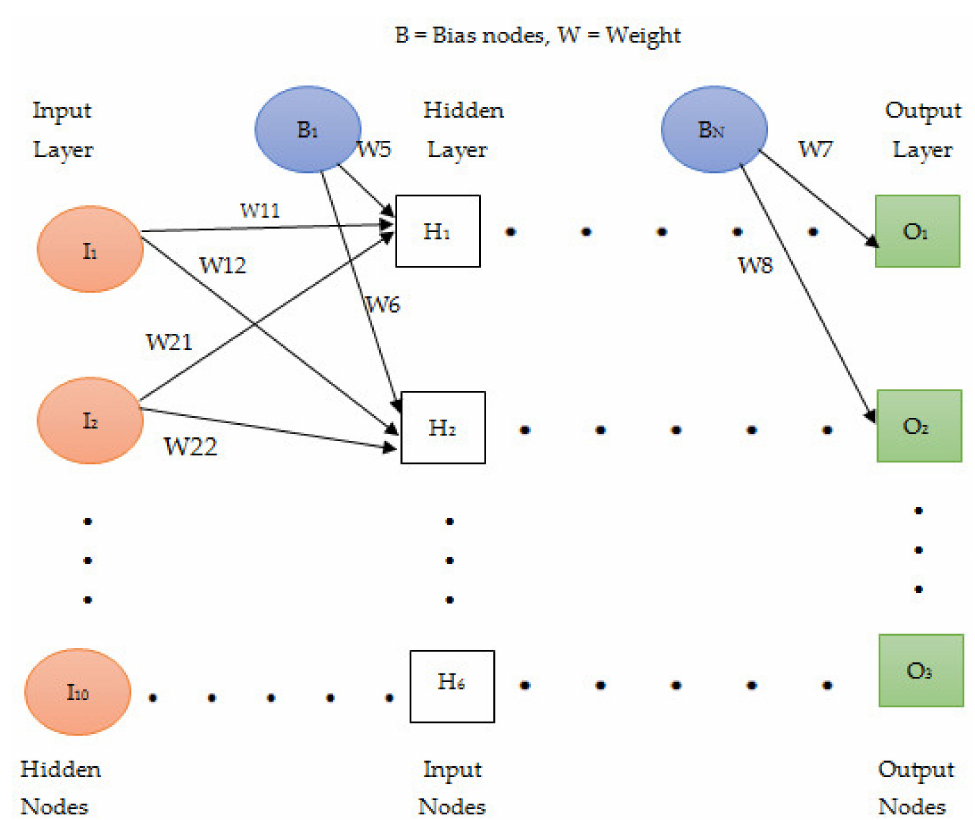
Figure 3. Arhitecture of an artificial neural network with one hidden layer, ten input nodes and three output nodes. Adapted from